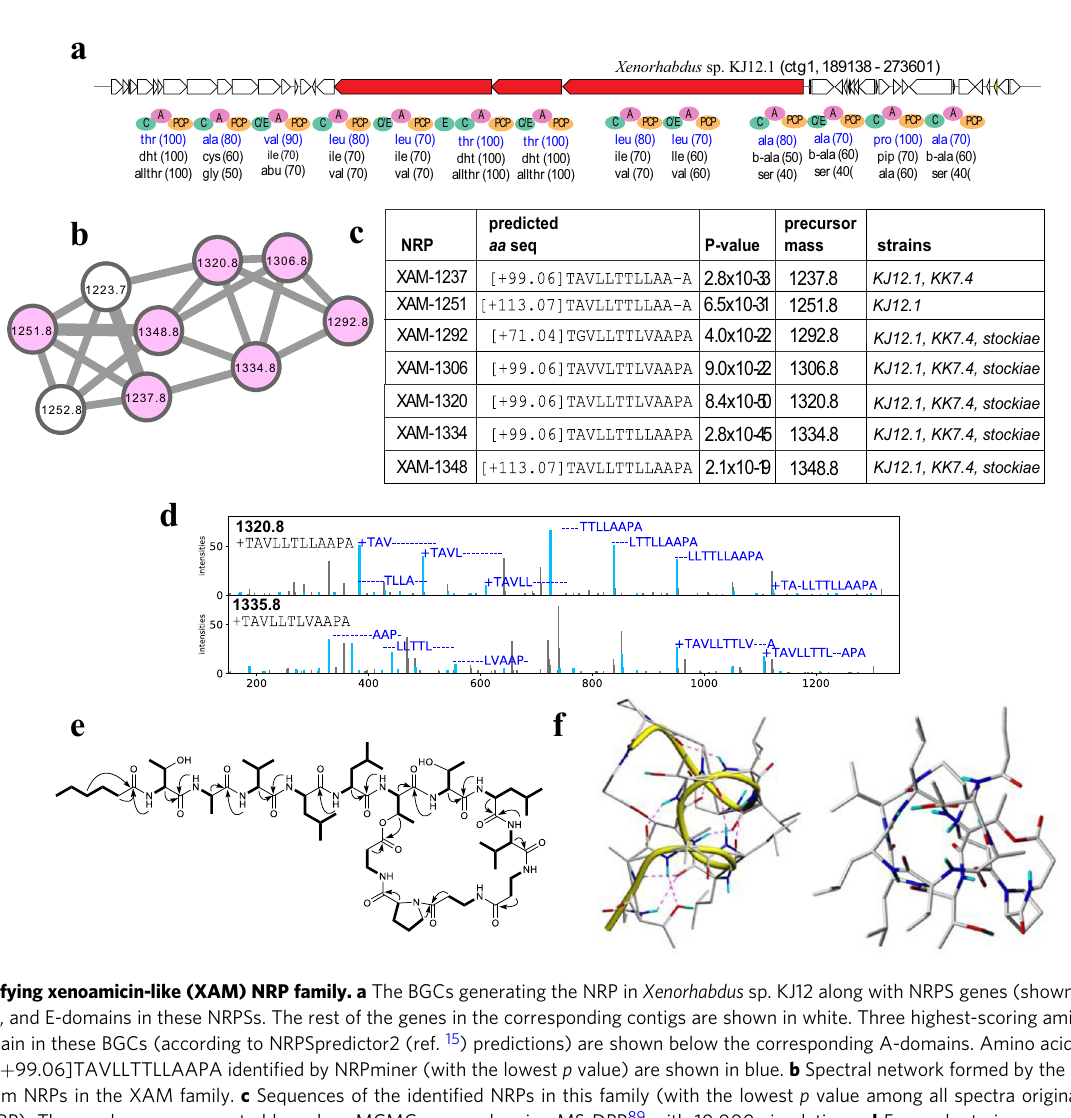
(Supplementary Fig. 22 and Methods section under “ Additional dataset . NRPminer discovered an NRP family that includes eight analysis for xenoamicin-like family ” ) and were also able to isolate the major derivative XAM-1320 from Xenorhabdus sp. KJ12.1 distinct NRPs, along with their BGC (Fig. 5). While the matched and to elucidate its structure by NMR including its 3D solution structure (Supplementary Tables 5 and 6 and Supplementary Figs. 25 – S29) that con fi rms its β -helical structure from the alternating D/L con fi gurations (con fi rmed by the advanced Marfey ’ s analysis; Supplementary Fig. 23 and “ Methods ” section) throughout the peptide chain from the presence of C/E domains, except for the C-terminal part shown in Fig. 5. XAM-1320 was also tested diversi fi cation, namely module skipping as previously observed in against protozoa and showed a good activity against T. brucei other NRPSs 61,65,66 . We con fi rmed the sum formula of XAM- rhodesiense (IC 50 [mg/L] 3.9) but much lower activity against Trypanosoma cruzi , Plasmodium falciparum and rat L6 cells (IC 50 [mg/L] 25.5, 56.2, and 46.0, respectively). Supplementary Figure Figs. and 21) and MS – MS experiments 24 provides information about the isolation and structure